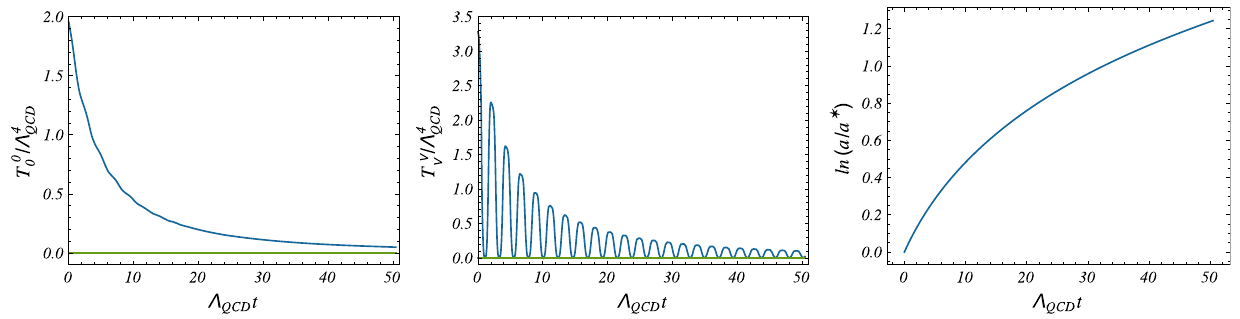
√ 3 e , Q 0 > 1, ξ (cid:3) 4, and ( t ) and T μ μ ( t ) are plotted 0 . The ampli- QCD